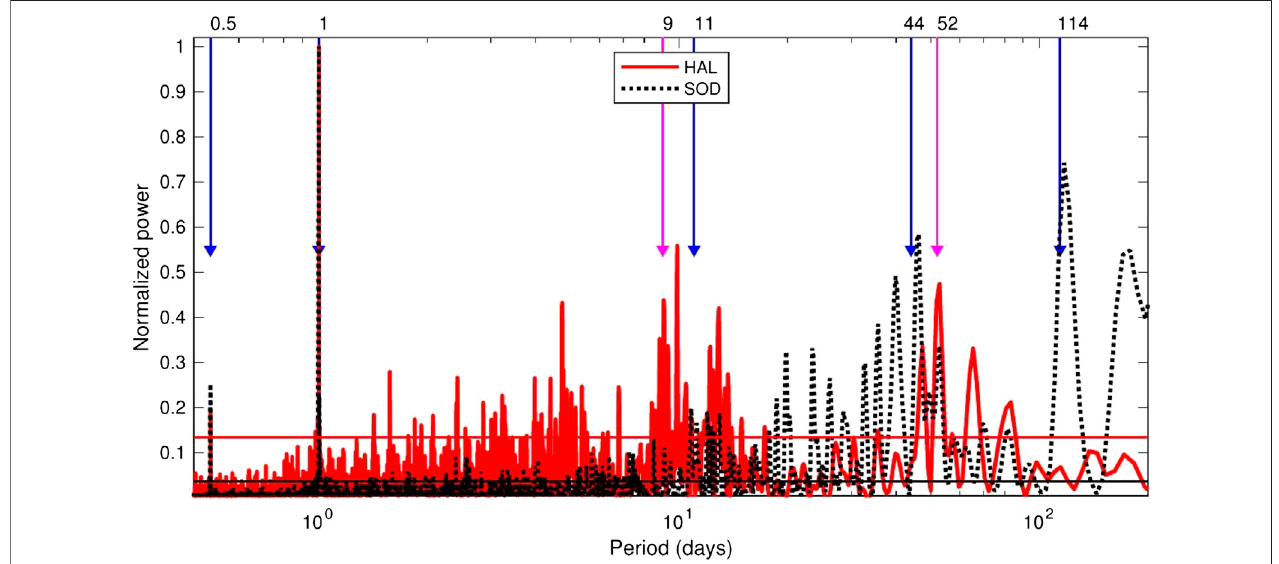
FIGURE 9 | Normalized Lomb-Scargle periodogram of PG hourly values for SOD (black dotted curve) and HAL (red continuous curve) stations. The black and red horizontal lines are the 98% signi fi cant levels, and the blue and magenta vertical lines are the signi fi cant oscillations found by the wavelet analysis for SOD and HAL, respectively. For the 0.5- and 1-day periods the blue and magenta curve are superposed.